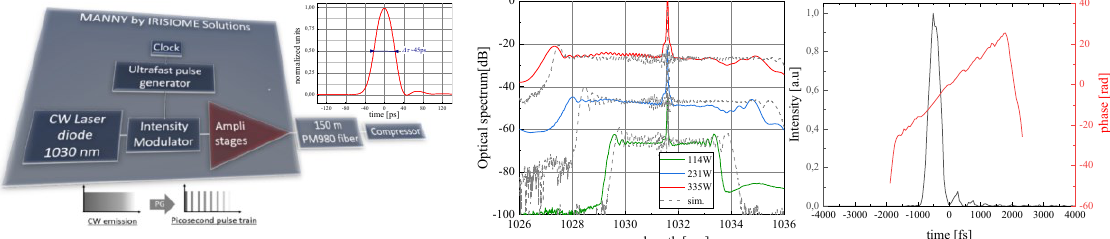
Fig. 1. (Left) Experimental setup for the laser system and measured optical pulse. (Middle) Simulated and measured spectra with different input powers level. (Right) FROG trace of the output pulses and (intensity and phase) at 10MHz repetition rate. Experimentally, we observe the onset of Stimulated Raman Scattering (SRS) (not considered in the simulations). However, despite the onset of SRS, the spectrum continues to broaden. A saturation of the spectral broadening occurs when the second order Stokes appears [3]. We compressed the output pulses using a homemade grating compressor (1750 l/mm) and measured the compressed pulses (30 nJ) with a single-shot FROG, the FWHM pulse duration is 377 fs (368 fs transform limited pulse). The temporal profile is clean, despite small post-pulses inherited from the ps pulse of the output of the amplifier. Indeed, the initial post pulses has created several post pulses during the nonlinear propagation. However, most of the energy, about 94%, is contained in the main pulse. The retrieved pulse durations are almost the same for the different repetition rates when the injected power is tuned at the input of the nonlinear fiber to obtain same spectral broadening. Usually, the compressor must be reoptimized when changing the laser output power since the chirp and spectral broadening vary with the peak power [4]. Therefore, it is possible to obtain the shortest pulse duration without changing the compressor length, while modifying the pulse repetition rate to realize unprecedented agility. The power tuning is not critical and can support up to 10% of variation with negligible impact on the pulse duration and shape. We have demonstrated an agile and simple alternative to mode-locked lasers. With this experiment we open new avenues in non-mode-locked femtosecond sources for application requiring agility and simple synchronization with low timing jitter. This paves the way to use this technology for instance in micromachining or other applications where high repetition rates are beneficial